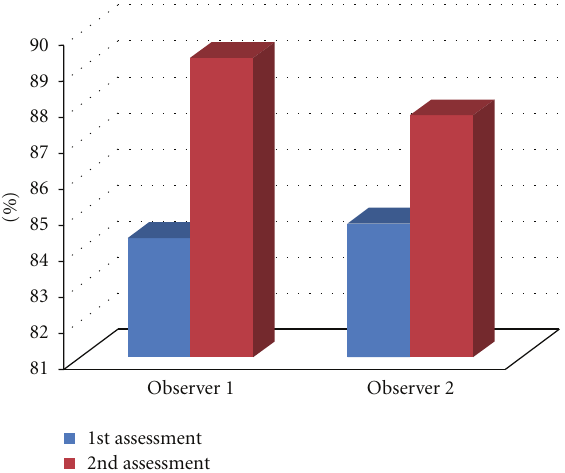
Figure 3: Agreement between the gold standard with each examiner and assessment, in the study of loci